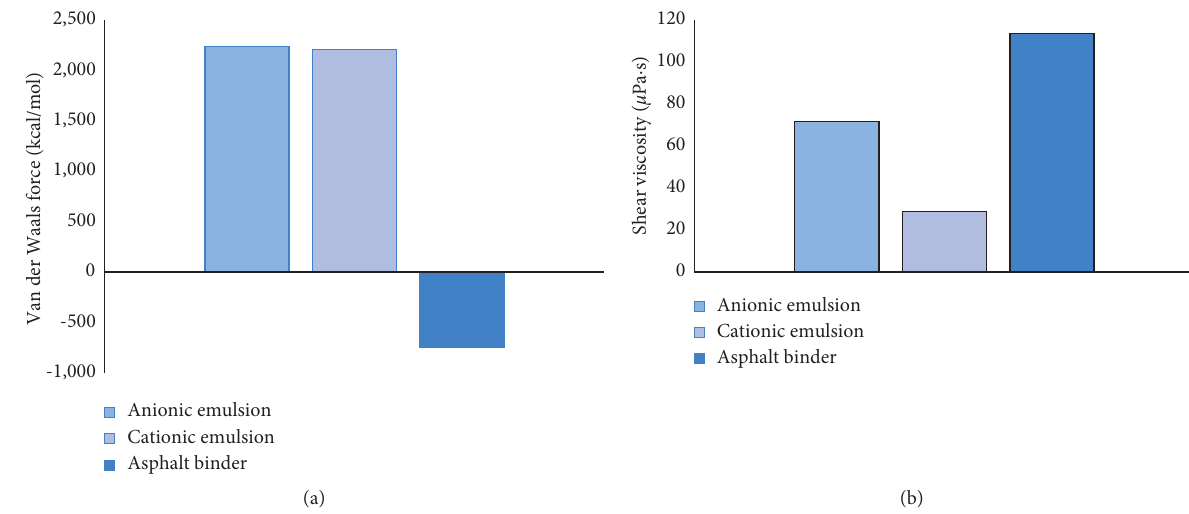
Figure 3: (a) The Van der Waals force of different kinds of samples. (b) The shear viscosity of different kinds of